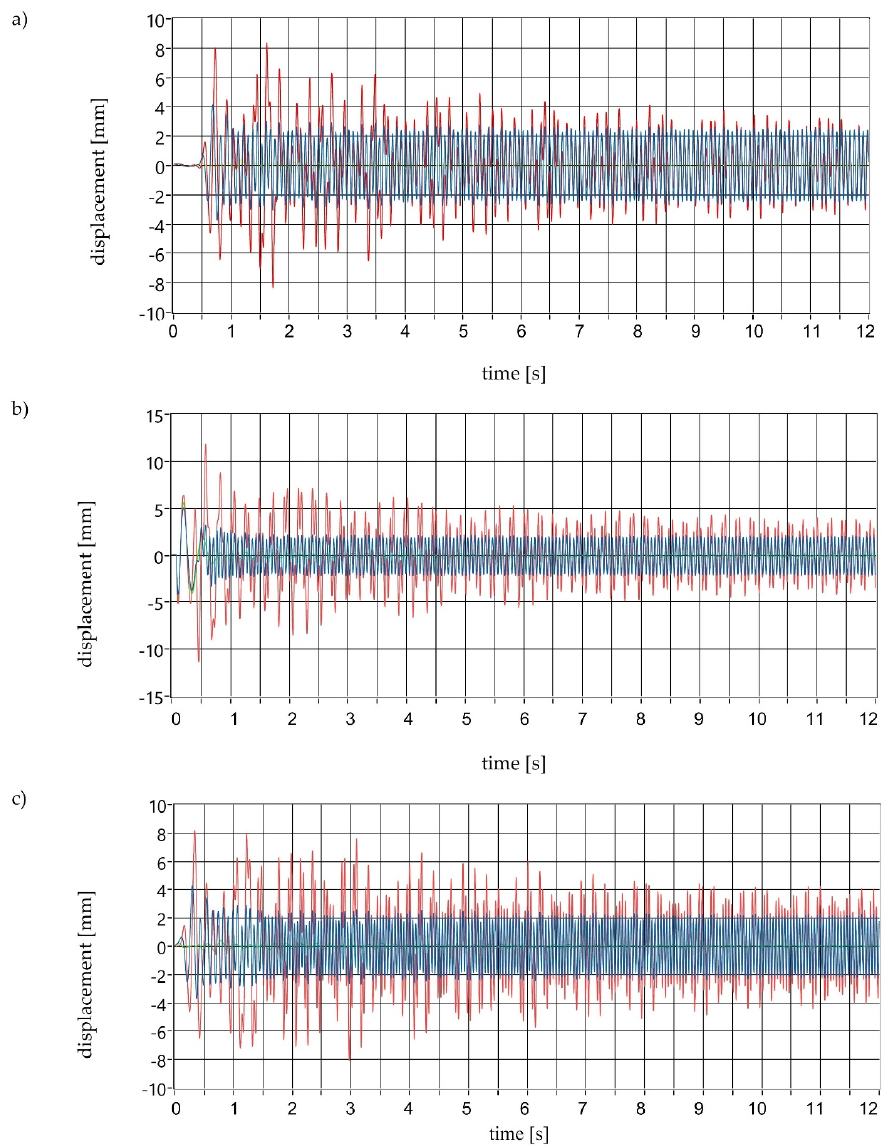
Figure 10. Time course of the new drive’s vibration amplitude measured at point 1L versus time (direction y-red, x-blue, z-green) during start-up for the rated frequency: ( a ) f = 13.2 Hz; ( b ) f = 16.5 Hz; ( c ) f = 19.8 Hz. Table 3. Maximum multiples of vibration amplitude values in the x